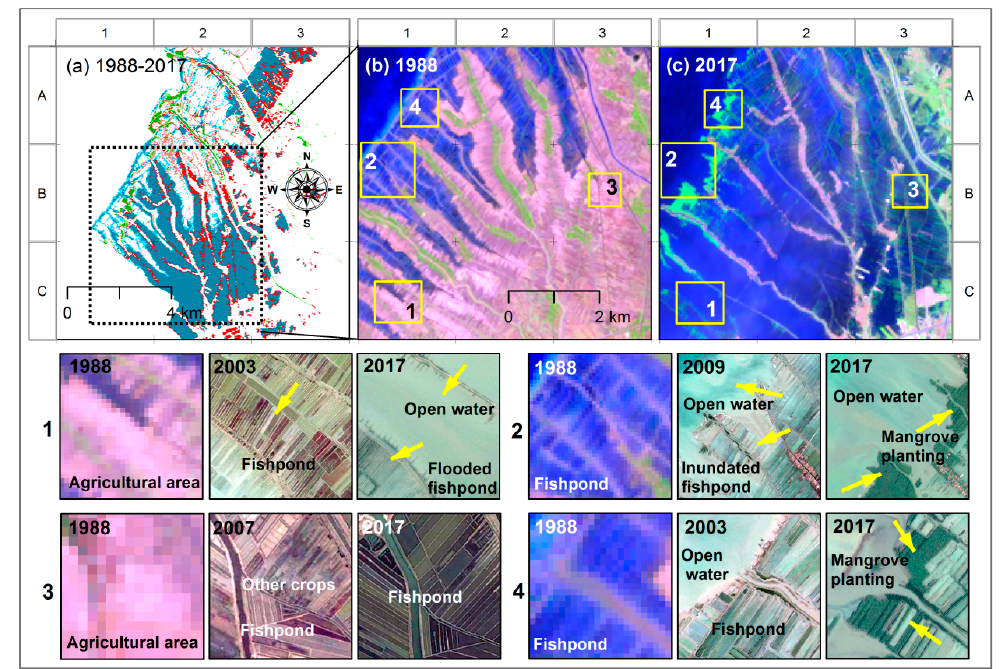
Figure 15. Changes of land use/cover observed in the east section. ( a ) Spatial distribution of changes from 1988 to 2017. Black-dashed rectangle shows the locations of Landsat images with RGB 542 displayed in ( b ) and ( c ) corresponding to areas experiencing massive erosion. The pink colour represents bare soil , green refers to vegetation and blue refers to water . The four yellow boxes show zoom-in areas. The 1988 Landsat and Google Earth images show the type of land use/cover. Agricultural areas, fishponds , mangroves , open water , and settlements were distinguished based on criteria described in the text.